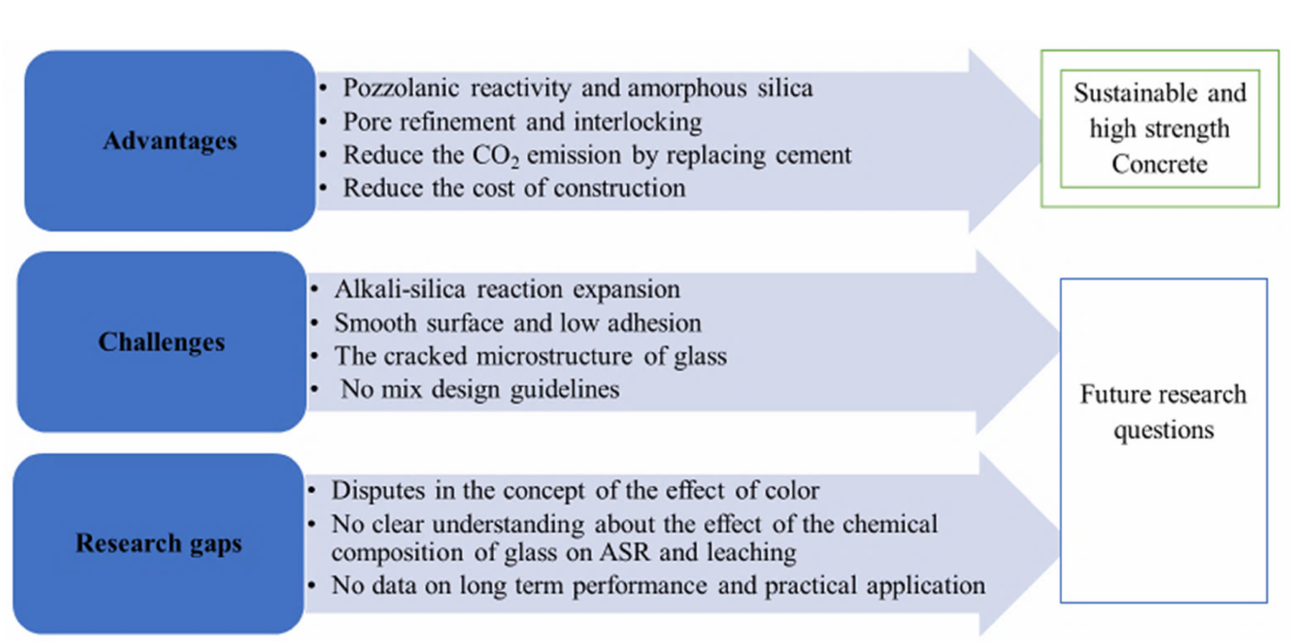
Figure 12. Advantages, challenges, and knowledge gaps of using WG as